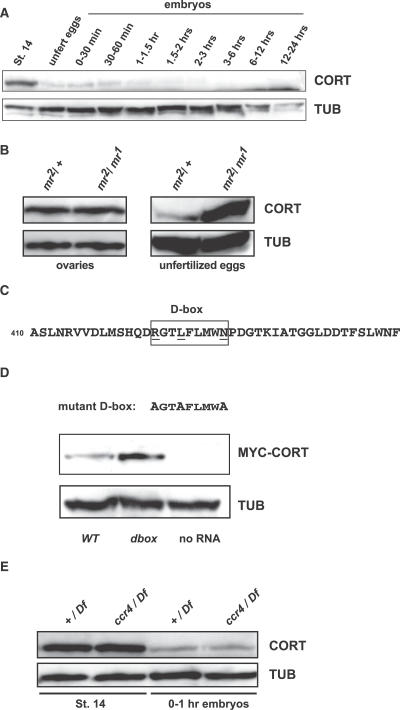
CORT Protein Becomes a Target of the APC/C after the Completion of Meiosis(A) Developmental western blot showing rapid drop in CORT levels in wild-type unfertilized eggs compared to stage 14 oocytes. Staged embryo extracts show decreasing levels of CORT as embryogenesis proceeds. Blot was probed with anti-α-Tubulin as a control.(B) CORT levels increase in mr mutants after the completion of meiosis. Western blot showing CORT levels in mr2/+ and mr2/mr1 ovaries and unfertilized eggs. By ImageJ analysis, band intensity of CORT in mr2/+ and mr2/mr1 ovaries is approximately identical. Band intensity of CORT in mr2/mr1 eggs is approximately 3.4-fold greater than CORT in mr2/+ eggs. Blots were probed with anti-α-Tubulin as a loading control.(C) Putative D-box sequence in C terminus of CORT (residues 424–432). Conserved residues are underlined.(D) D-box sequence in CORT is required for its degradation in early embryos. All three conserved residues were mutated to alanine in D-box mutant CORT. Embryos (0–30 minute) were injected with myc-cort wild-type (WT) or D-box mutant (dbox) RNA or buffer alone (no RNA). Western blot showing levels of wild-type or D-box mutant MYC-CORT in injected embryos. D-box mutant CORT is stabilized compared to wild-type CORT. By ImageJ analysis, band intensity of D-box mutant MYC-CORT is approximately 2.7-fold greater than wild-type MYC-CORT. This blot is representative of five independent experiments, which all gave similar results. Blot was probed with anti-α-Tubulin as a control.(E) ccr4 is not required to lower CORT protein levels in early embryos. Western blot showing levels of CORT in ccr4/Df and +/Df sibling control stage 14 oocytes and 0–1-h embryos. Blots were probed with anti-α-Tubulin as a loading control.